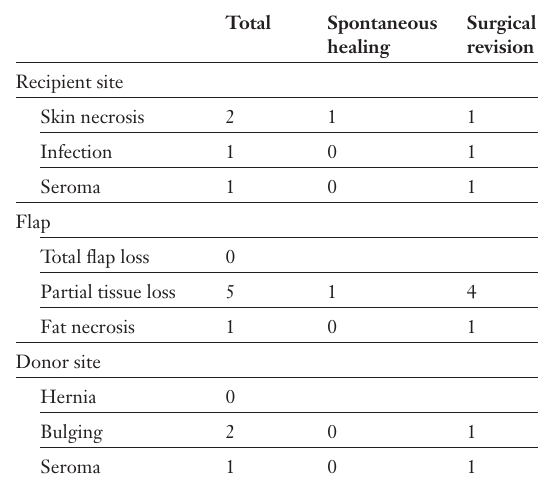
Table 3 Complications in reconstructed breast (recipient site, flap) and at abdominal donor site (n = 32 patients). The wound healing complica- tions healed sponta- neously (n = 2) or required surgical revision (n =